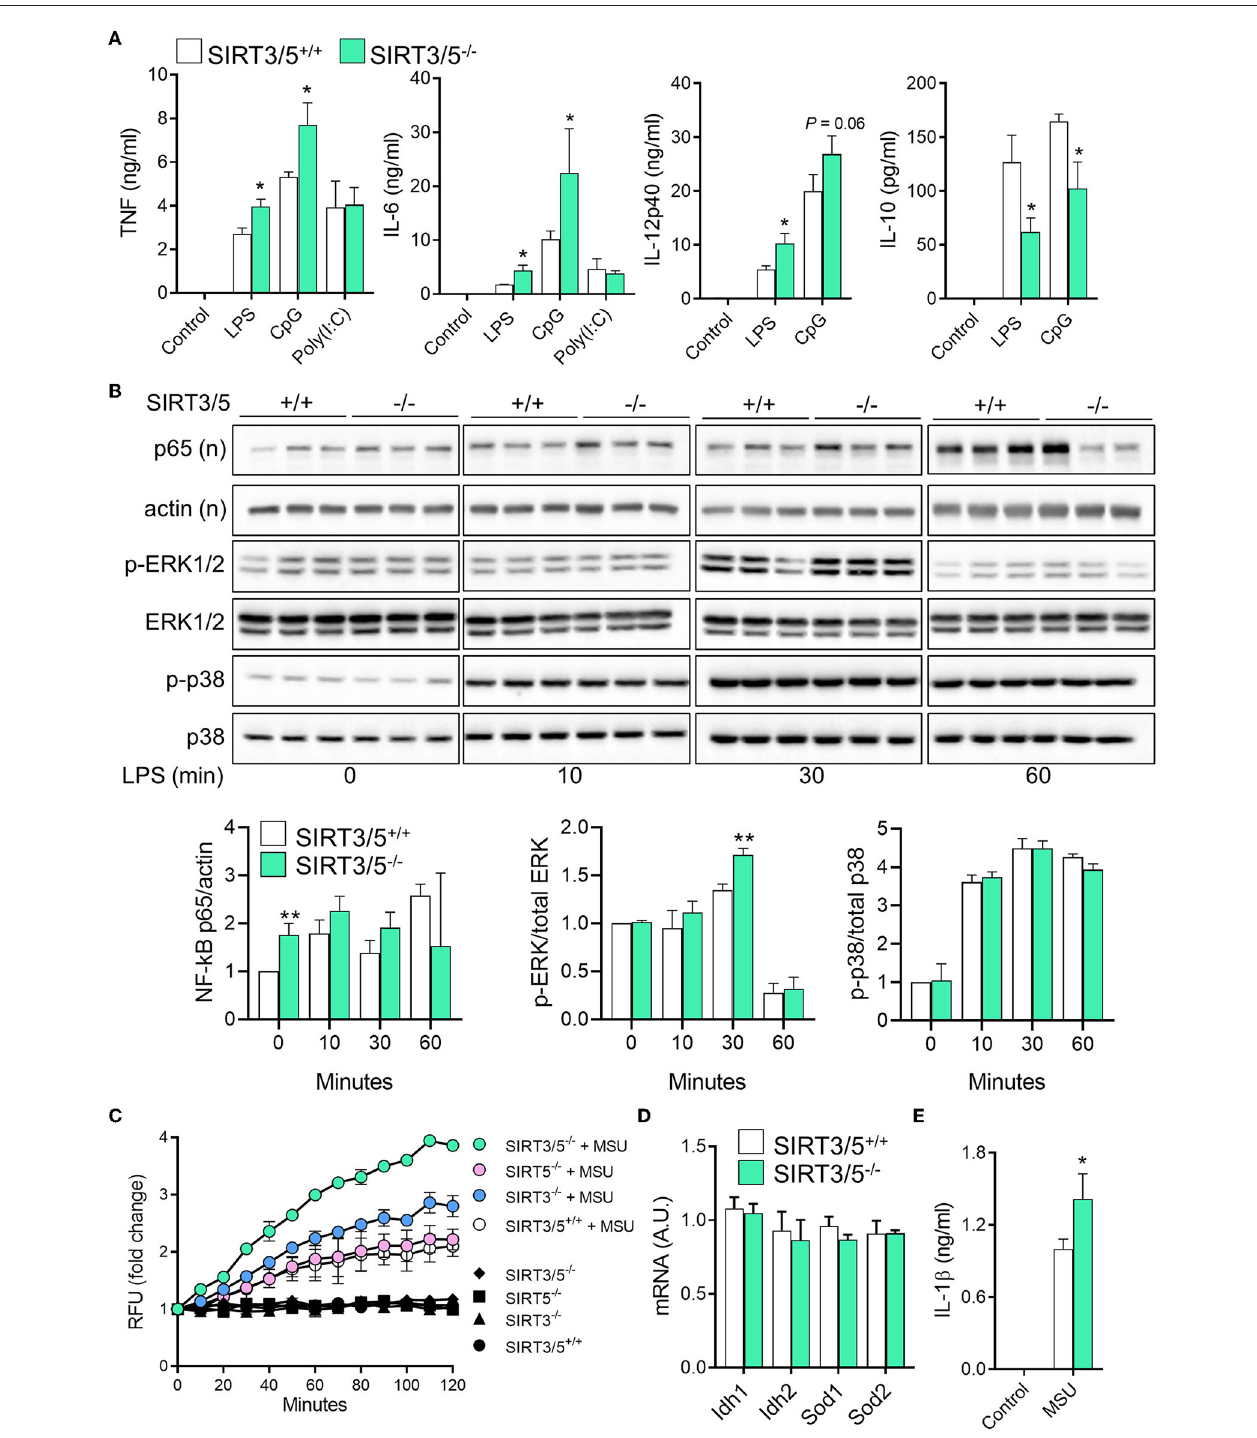
FIGURE 3 | SIRT3/5 deficient macrophages display an enhanced proinflammatory profile. (A) SIRT3/5 + / + and SIRT3/5 − / − BMDMs were exposed for 24h to LPS (10ng/ml), CpG (1 µ g/ml), and poly(I:C) (10 µ g/ml). TNF, IL-6, IL-12p40, and IL-10 concentrations in cell culture supernatants were quantified by ELISA. Data are means ± SD from one experiment performed with four mice. (B) SIRT3/5 + / + and SIRT3/5 − / − BMDMs were exposed for 0, 10, 30, and 60min to LPS (10ng/ml). Nuclear (n) and total protein extracts were used to analyze NF- κ B p65, and phosphorylated (p) and total ERK1/2 and p38. Signals were quantified